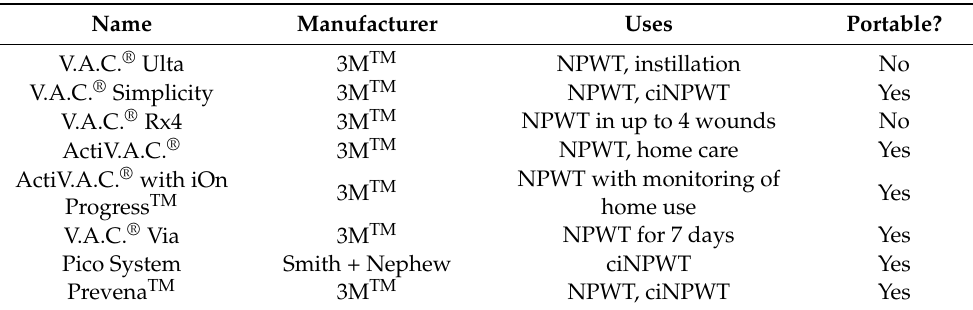
Table 1. Currently Available NPWT